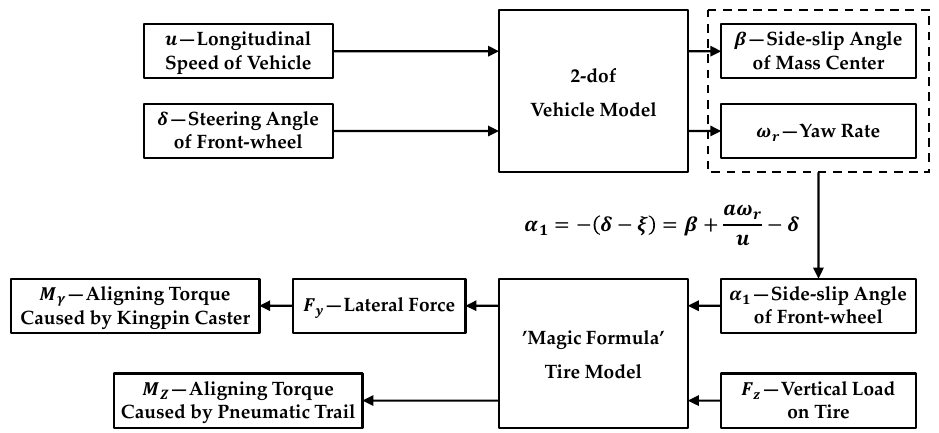
Figure 6. Solution procedure of the aligning torques caused by the kingpin caster and pneumatic trail.